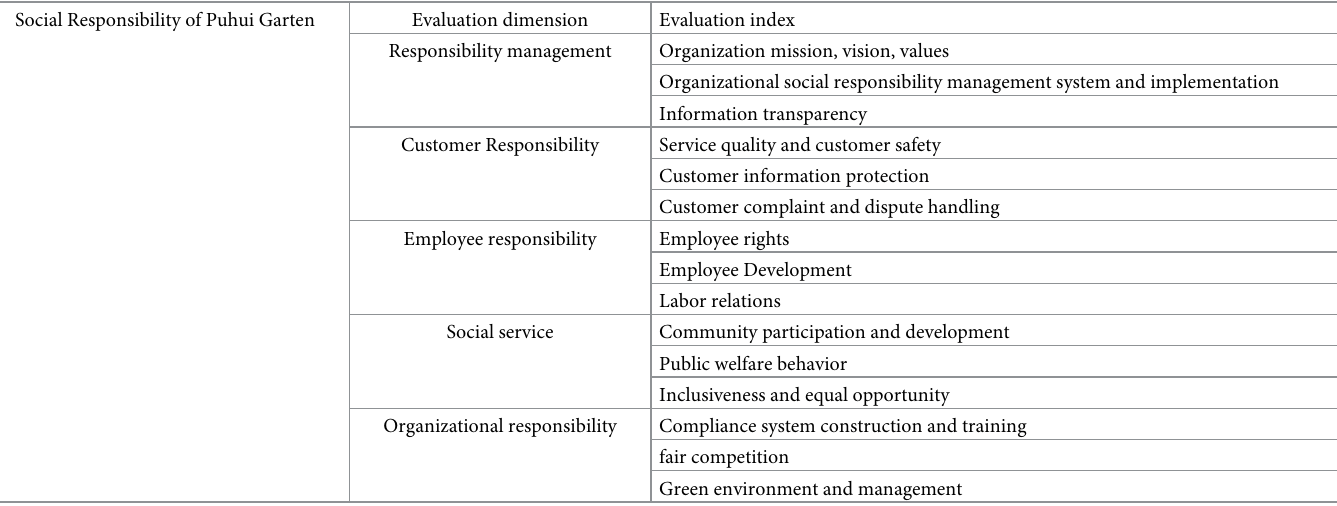
Table 1. Scope of social responsibility evaluation index of Puhui